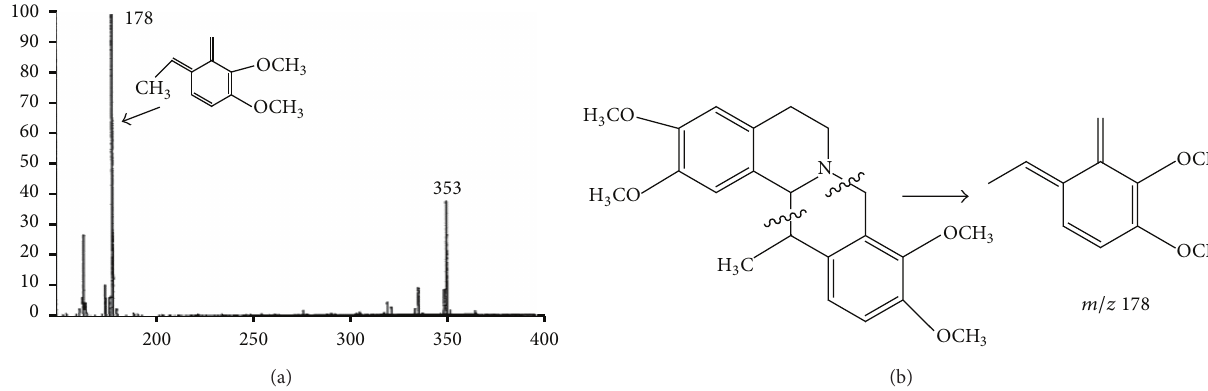
Figure 3: The mass spectrum (EI) of thalictricavine and fragmentation pathway of (+)-corydaline. (a) The mass spectrum of thalictricavine was performed by Rueffer et al.